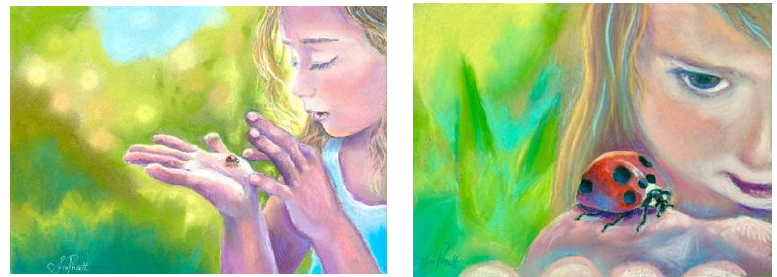
Figure 3. Mindfulness as a pathway to wisdom and flourishing, engenders self-awareness, purpose, and meaning—with a sense of connectivity to all life that promotes fulfilment, social concern, and environmental responsibility. The long-term personal and societal benefits are likely to be greatest when these approaches are introduced early in life (artwork by S.L.P.).